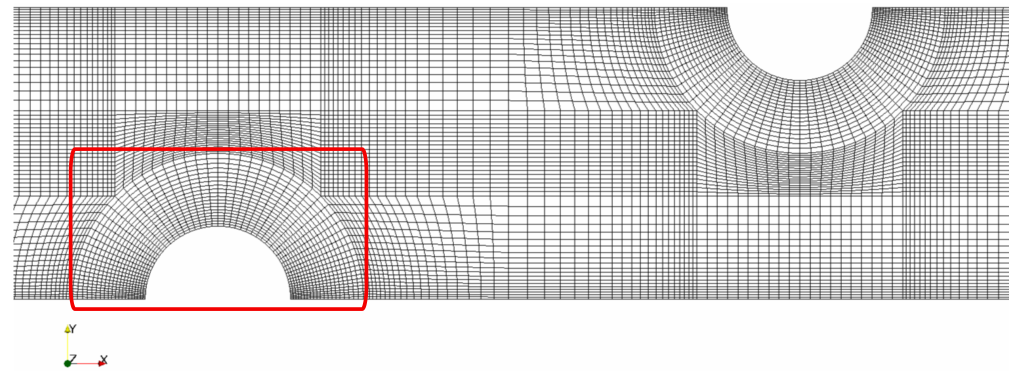
Figure 4. Local grid refinement near the walls of the cylindrical corrugated spacer-filled channel. The coarsest mesh in the local grid refinement process was depicted due to better visibility. The region around the corrugation which goes under local refinement process is confined in a red square.